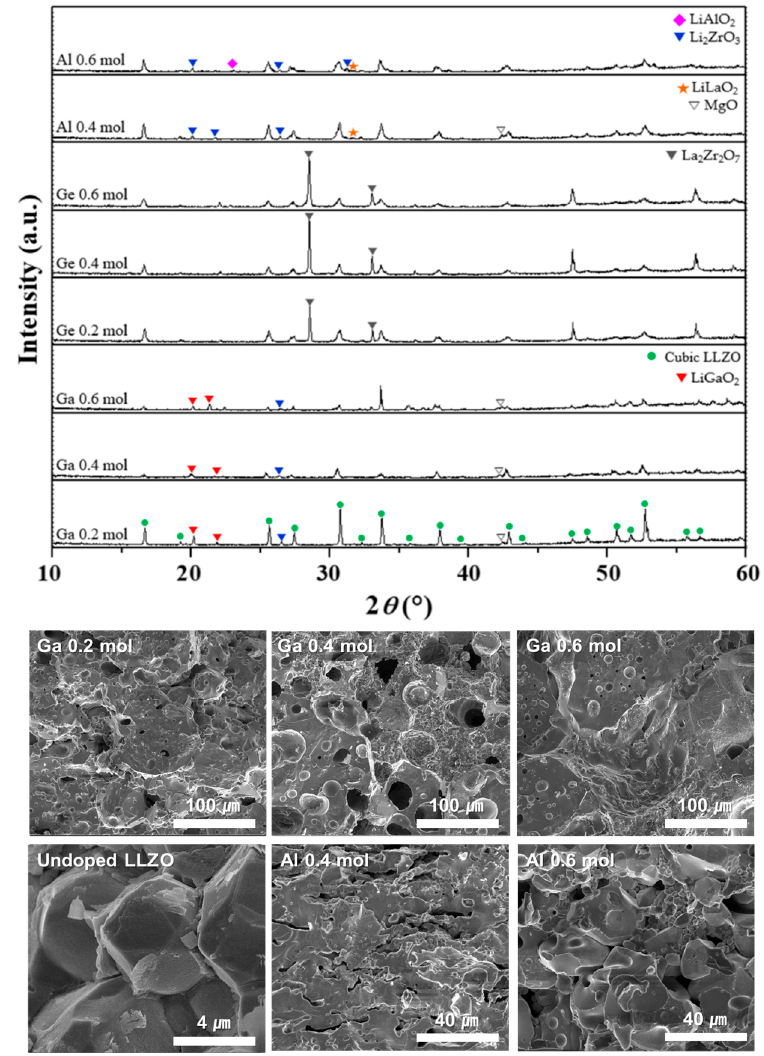
Figure 4. Crystal structure and morphology of A-doped LLZO ceramics (mono-doping of the Li + site with 0.2–0.6 mol Al or Ge): ( a ) XRD patterns and ( b ) FE-SEM images of the fracture surfaces.